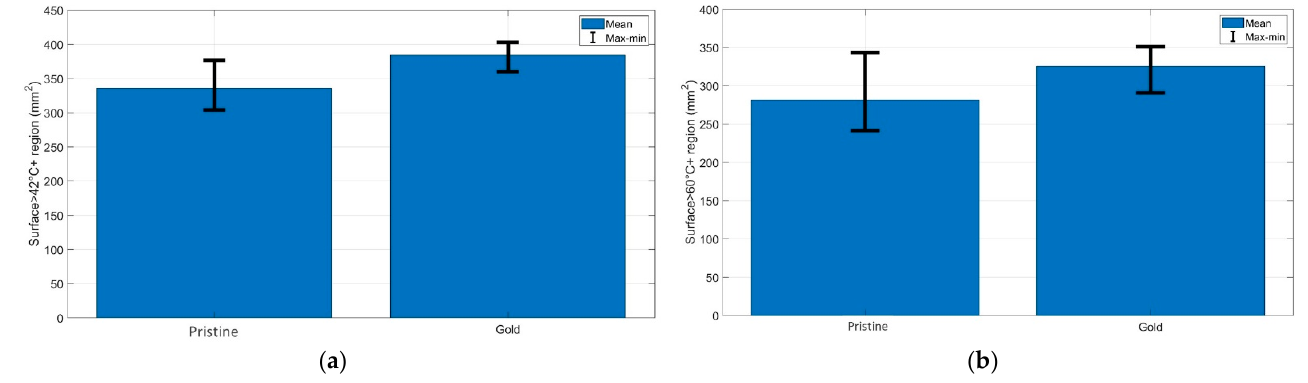
Figure 4. Evaluation of the surface area exposed to temperatures exceeding ( a ) 42 ◦ C and ( b ) 60 ◦ C at